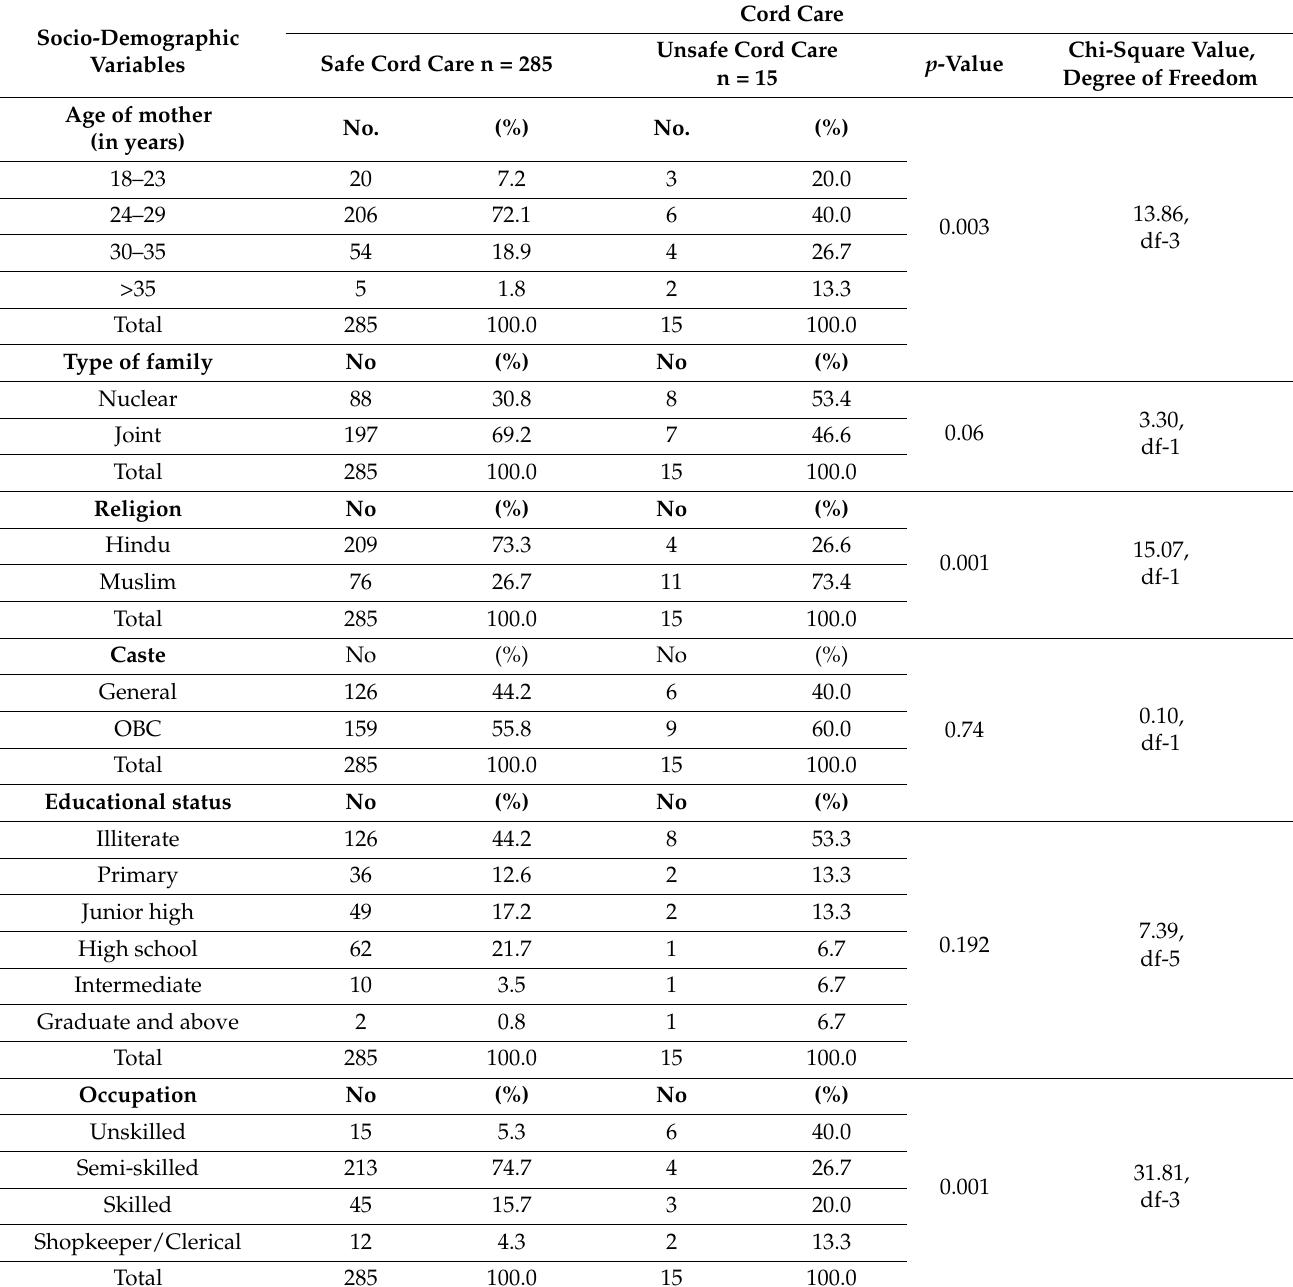
Table 3. Socio-demographic factors influencing Cord care